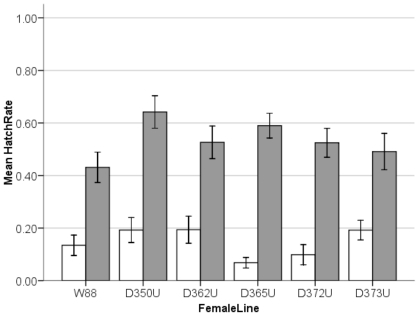
Susceptibility to CI of uninfected females from recently collected D08 lines and the old lab-maintained W88, to CI.Mean hatch of females from seven-day-old (white bars), and fourteen-day-old (grey bars) infected males. Error bars show ±1 SE of the mean.